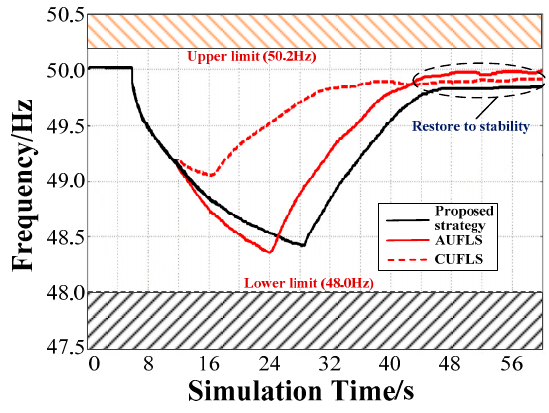
Figure 6. The frequency recovery process of each strategy under scenario-1.